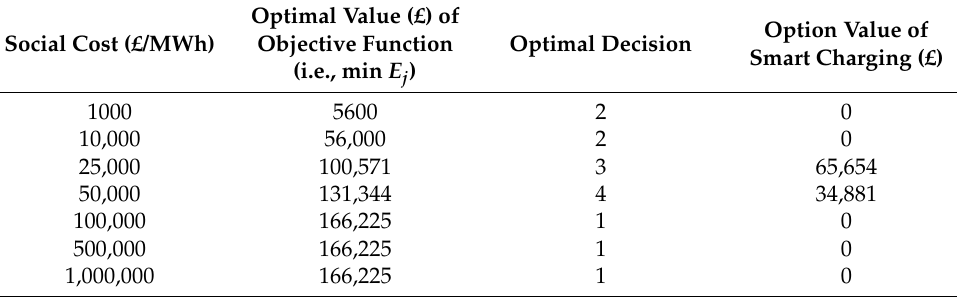
Table 4. Sensitivity analysis on social cost, using